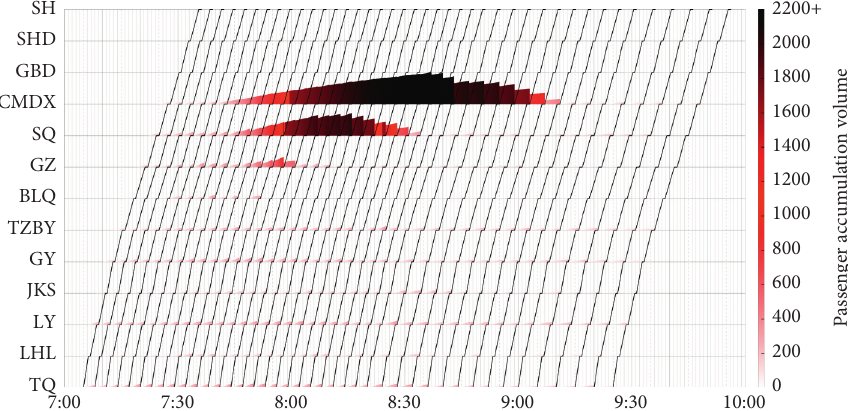
Figure 8: The timetable and passenger accumulation for